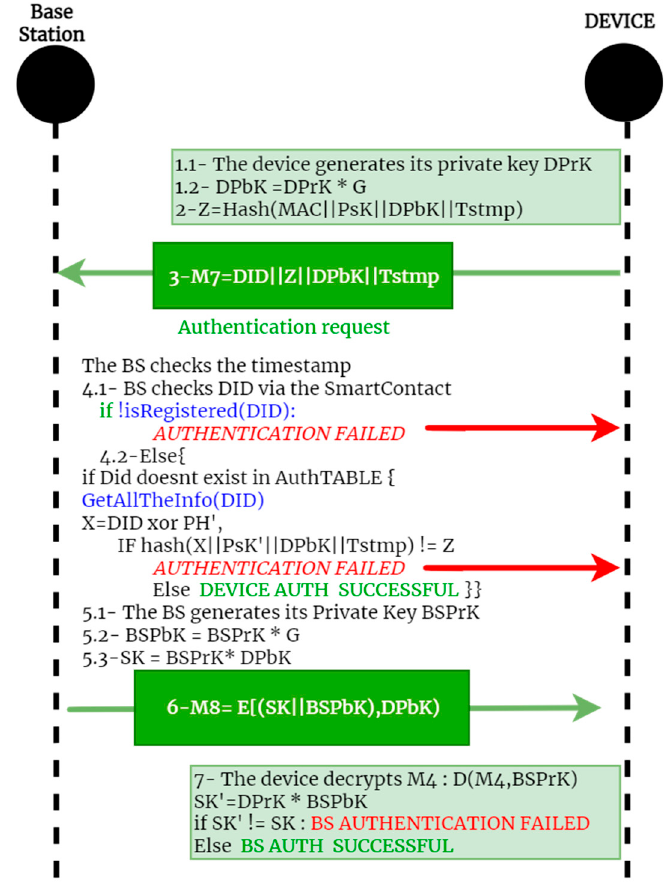
Figure 7. Registration phase .